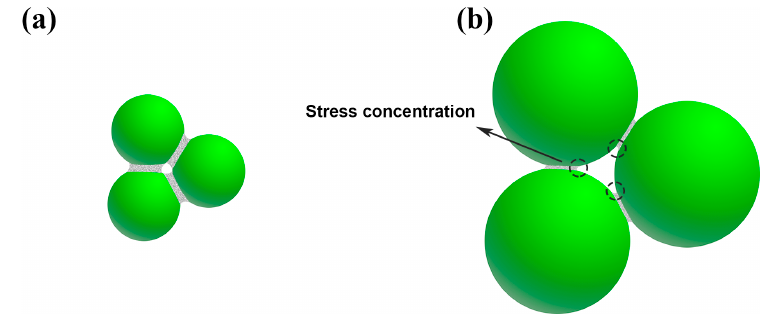
Figure 5. Schematic illustration of the sintering neck in porous L-SiC ceramics from ( a ) small particles and ( b ) large particles.